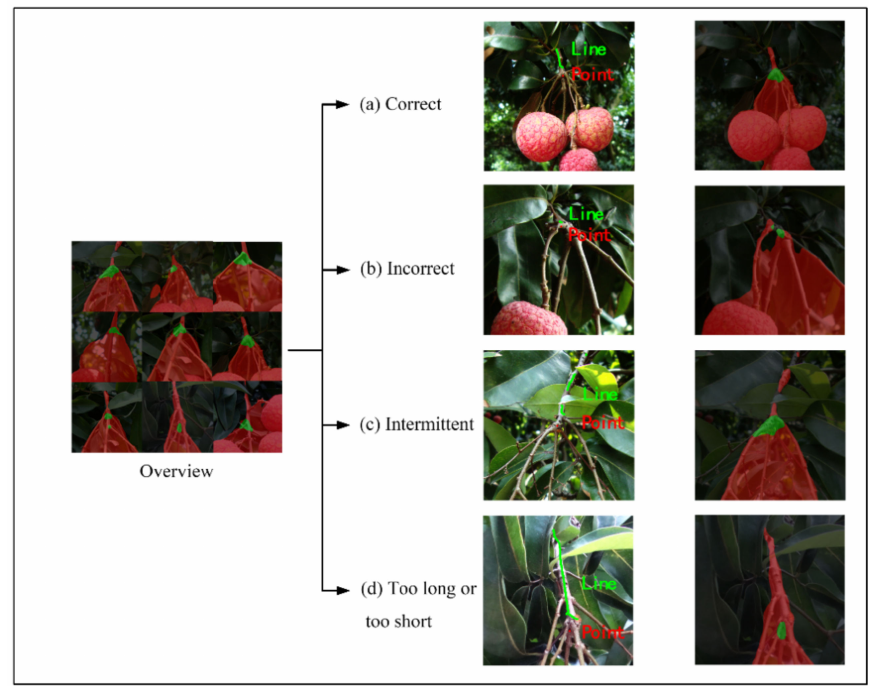
Figure 18. Four categories: ( a ) correct; ( b ) incorrect; ( c ) intermittent; ( d ) too long or too short.